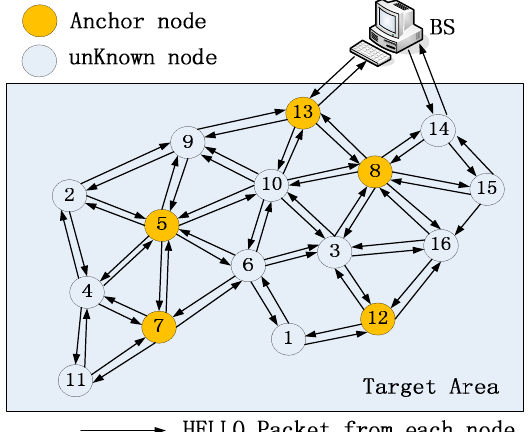
Figure 1. Illustration of gathering the information of nodes by BS.